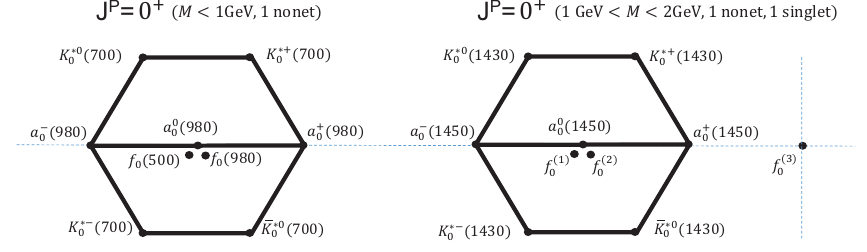
Figure 1. Spectroscopic classification of scalar mesons below 2 GeV in terms of two SU (3) nonets and a singlet. We do not identify the f 0 states above 1 GeV, because their mixing pattern to form the observed f 0 (1370), f 0 (500) and f 0 (1710) is still under